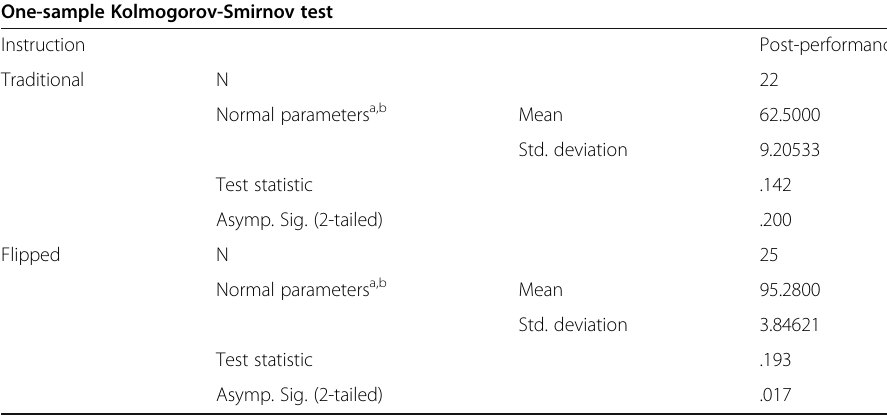
Table 13 Normality test (post-performance) One-sample Kolmogorov-Smirnov test